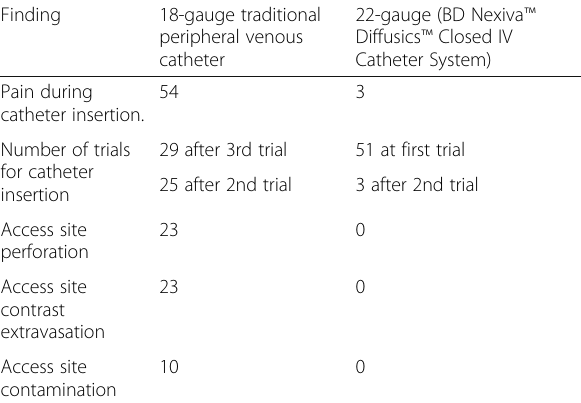
Table 1 Comparison of complications between 18-gauge non- fenestrated IV catheter and 22-gauge fenestrated IV catheter Finding 18-gauge traditional 22-gauge (BD Nexiva ™ Diffusics ™ Closed IV peripheral venous catheter Catheter System) Pain during 54 3 catheter insertion. Number of trials 29 after 3rd trial 51 at first trial for catheter 3 after 2nd insertion